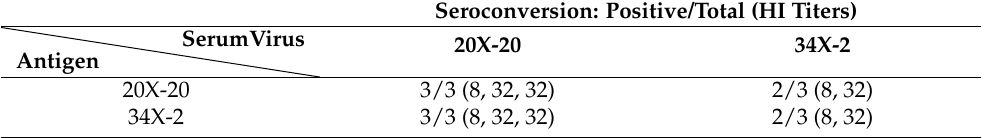
Table 4. Seroconversion in 6-week-old BALB/c mouse infected with H7 isolates and antigenic analysis of H7 isolates. Serum was collected on 14 dpi and treated for 18 h with a receptor-destroying enzyme. Seroconversion was confirmed using the hemagglutination inhibition (HI)